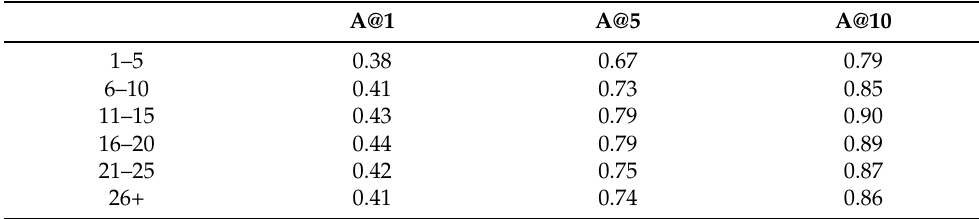
Table 5. The effectiveness of CodeHunter with different complexity of query descriptions. A@1